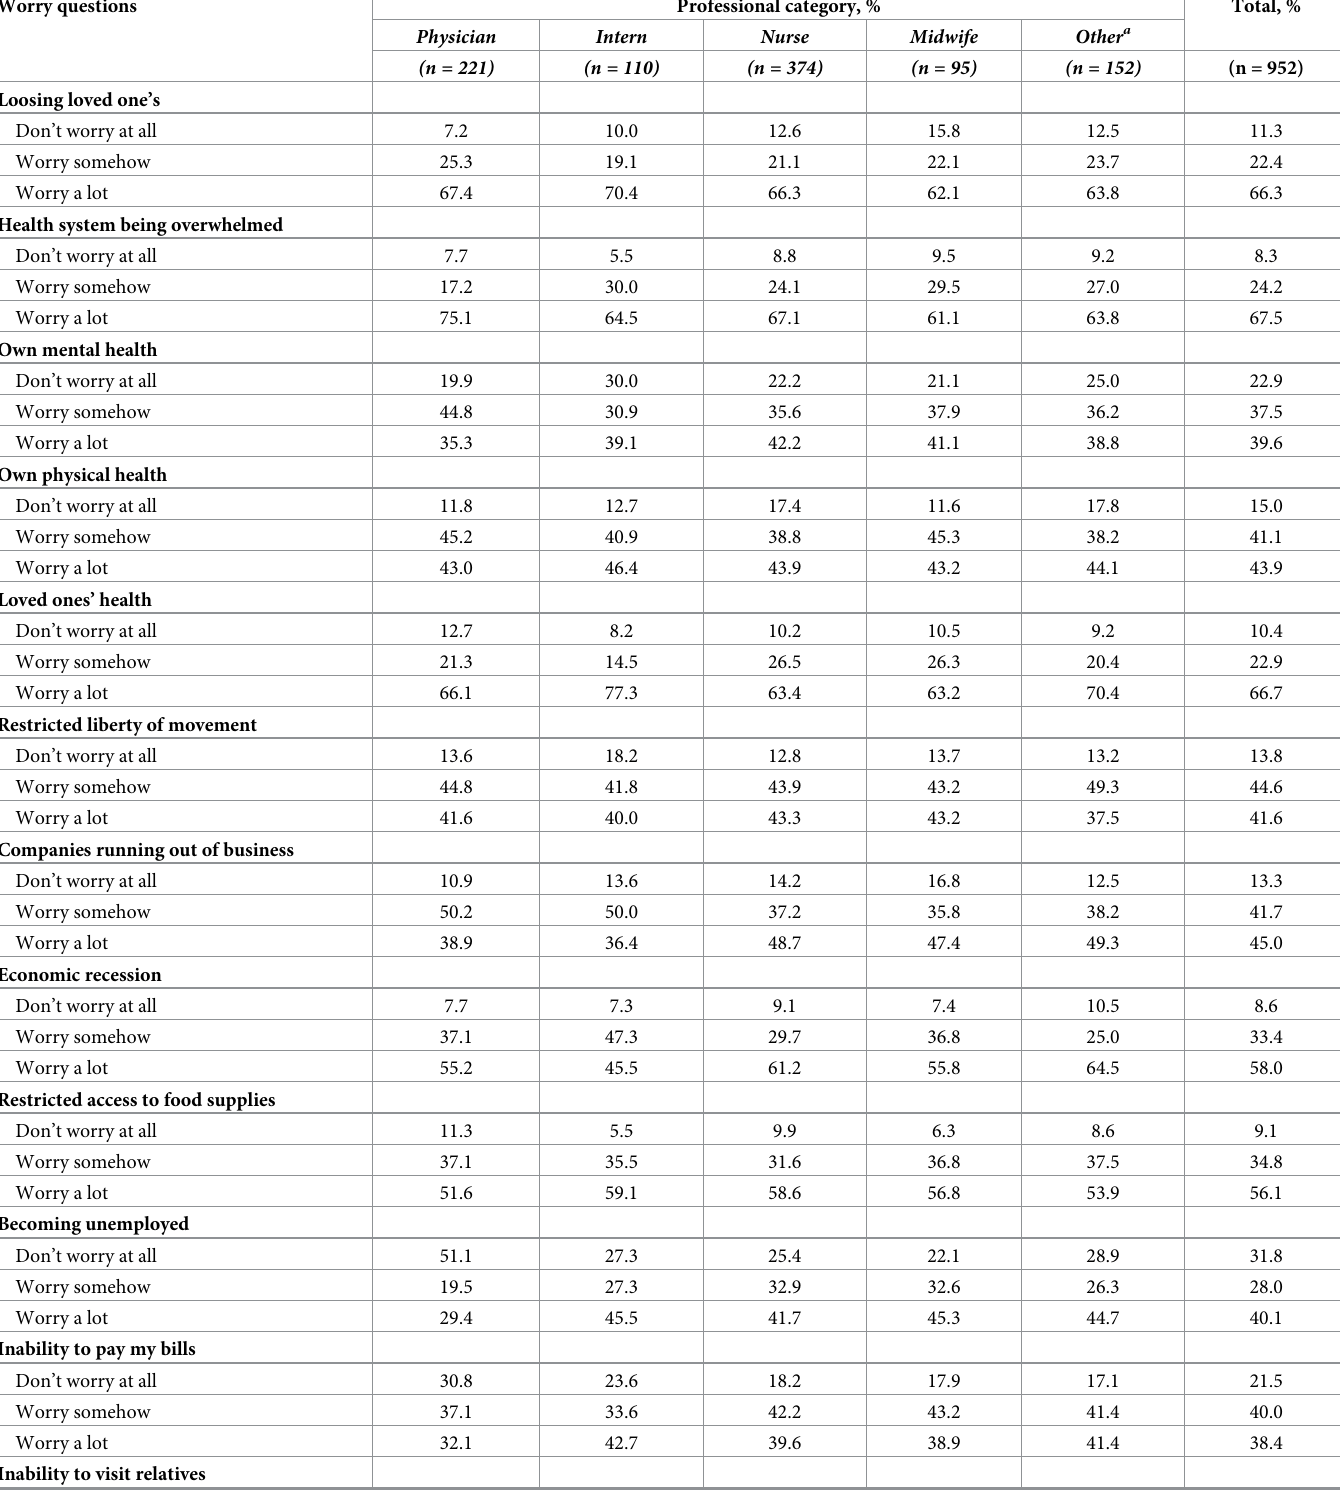
Table 4. Healthcare professional’s worry about COVID-19 crisis by professional category (N = 12 items). Worry